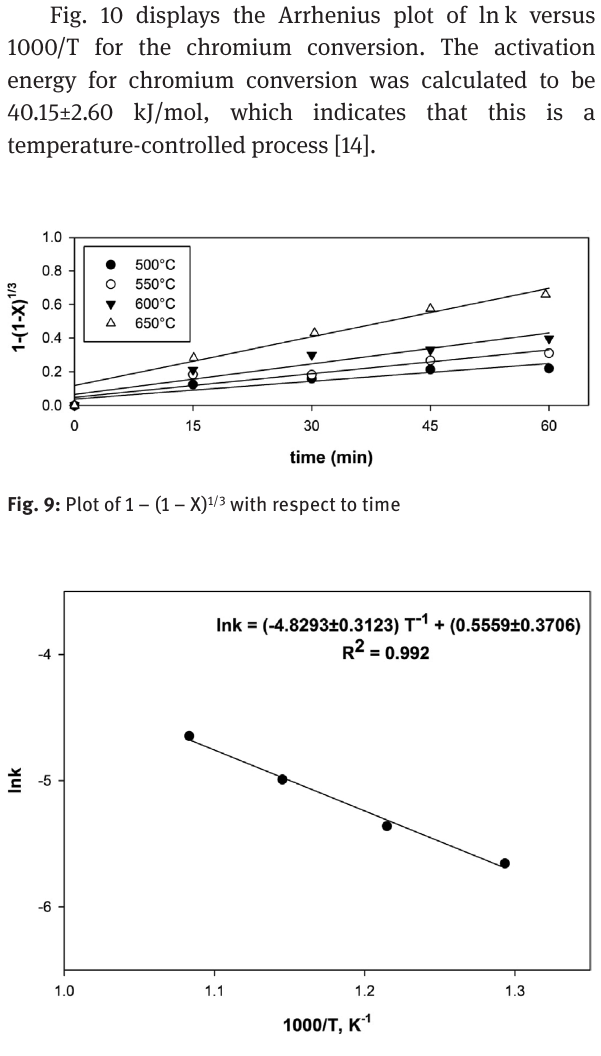
Fig. 10: Arrhenius plot of ln k vs.